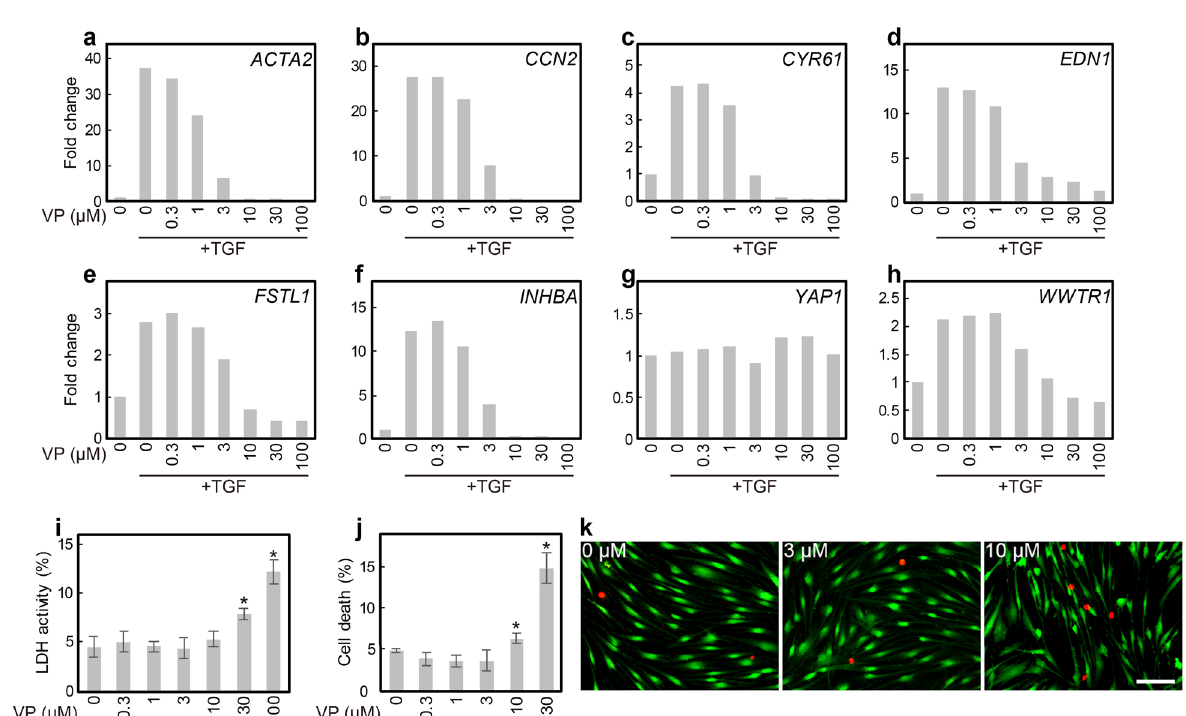
Figure 3. Verteporfin inhibited TGF-β1-induced YAP/TAZ activation in HVOX fibroblasts. HVOX fibroblasts were treated with or without 10 ng/mL TGF-β1 and 0–100 µM verteporfin (VP) for 24 h. Expression of ACTA2 ( a ), target genes of YAP/TAZ ( b CCN2 ; c CYR61 : d EDN1 ; e FSTL1 ; f INHBA ), YAP1 ( g ), and WWTR1 ( h ) were analyzed by qPCR. Cytotoxicity of VP was analyzed by LDH ( i ) and LIVE/DEAD cell viability assays (j; data shown as mean ± SD in i and j; n = 5; * p < 0.05, Dunnett’s test). Representative images of live (green) and dead (red) cells respectively stained with calcein AM and ethidium homodimer-1 (k; bar = 100 YAP/TAZ inhibition decreased TGF-β1-induced fibrotic gene expression. HVOX fibroblasts were treated with verteporfin, a YAP/TAZ inhibitor, to interrogate YAP/TAZ involvement in myofibroblast differen- tiation. TGF-β1-mediated gene regulation was inhibited by verteporfin in a concentration-dependent manner (Fig. 3a–f). Expression of YAP was not altered by verteporfin (Fig. 3g). In contrast, WWTR1 upregulation by TGF-β1 was reversed by verteporfin (Fig. 3h). The inhibitory effect of vertporfin was observed at ~ 1 µM, but was